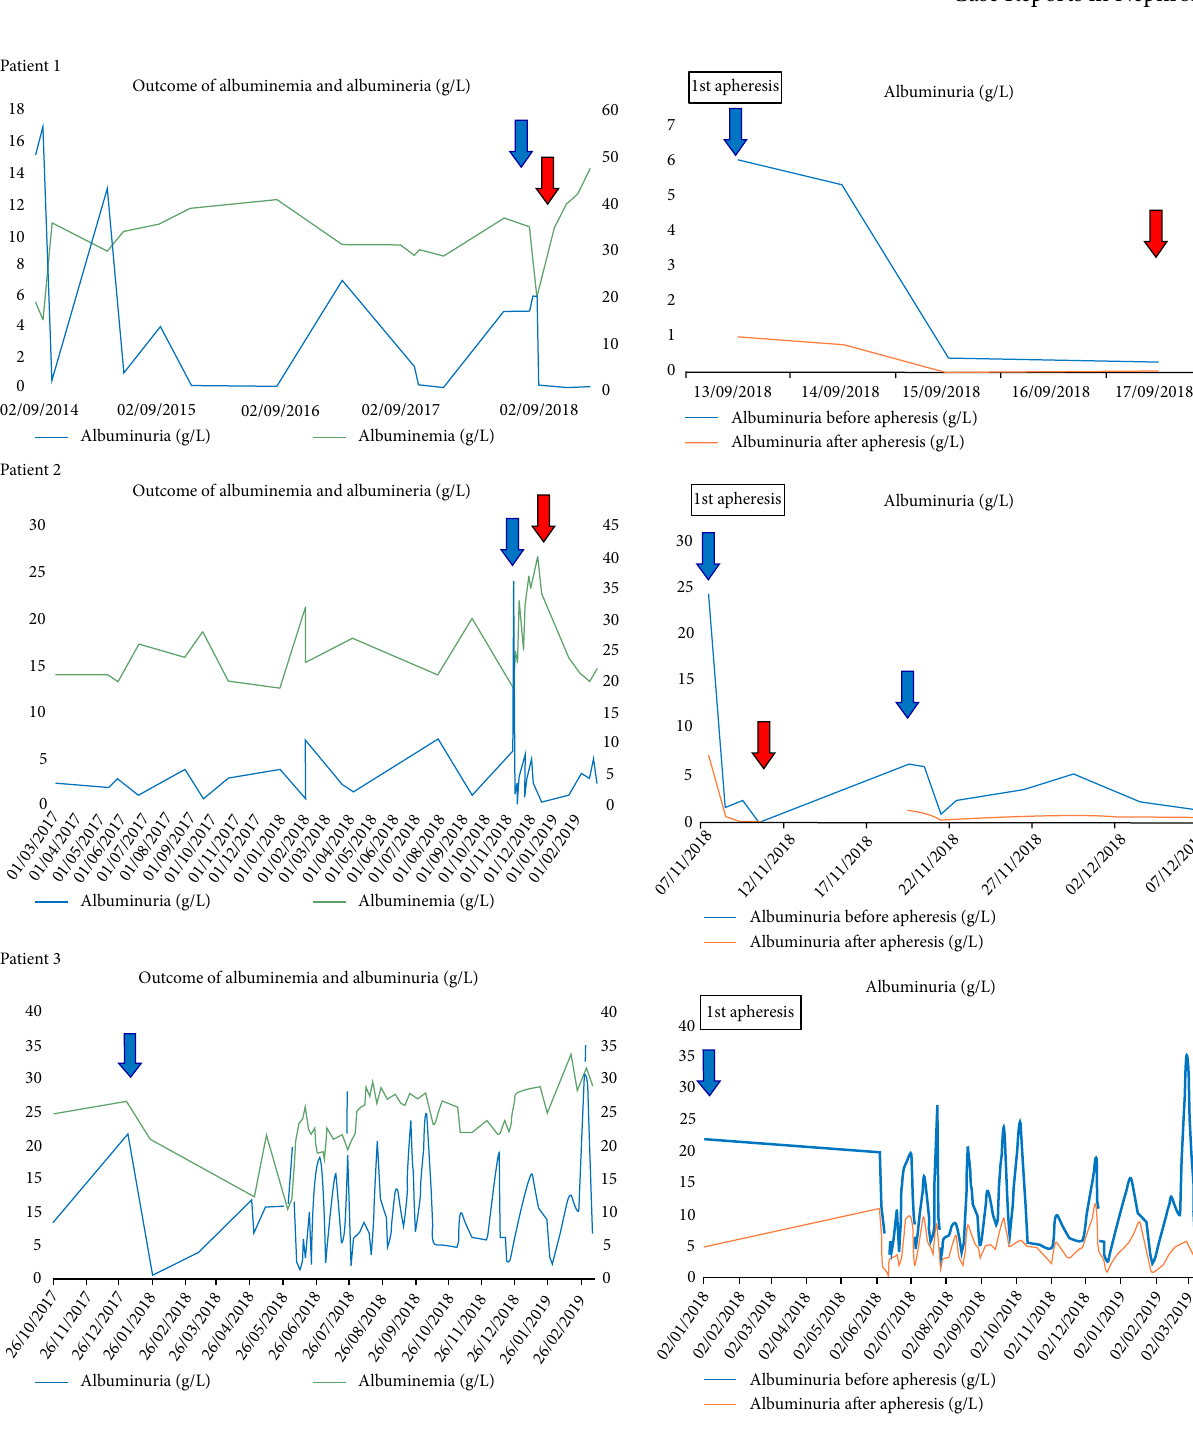
Figure 1: Outcome of albuminemia and albuminuria (g/L) for three patients. The blue arrow corresponds to the beginning of apheresis therapy and the red arrow corresponds to the stop of apheresis therapy. On the x axis are dates of the sessions and y axis on the left side albuminuria (g/L) and on the right side albuminemia